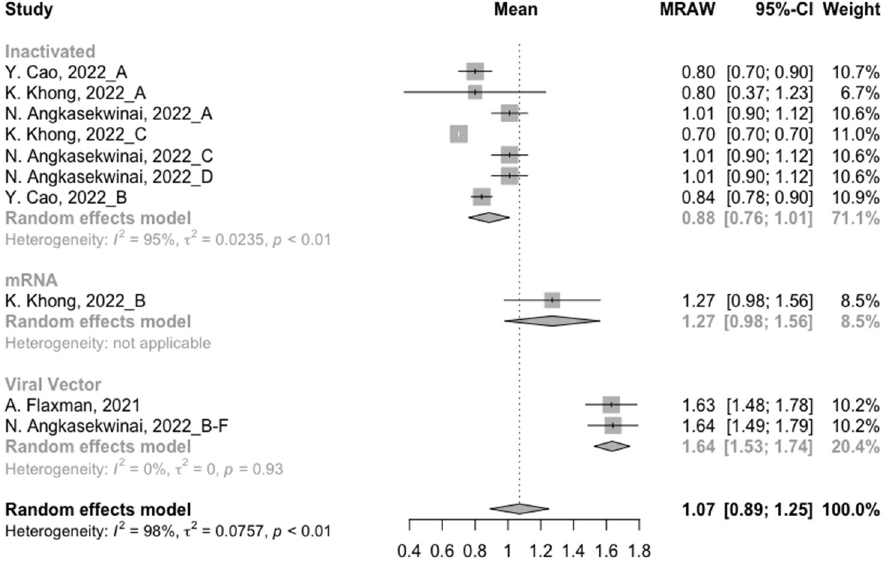
Figure 3. Forest plot of the pooled log-transformed neutralization titers against the Beta variant before booster vaccination.